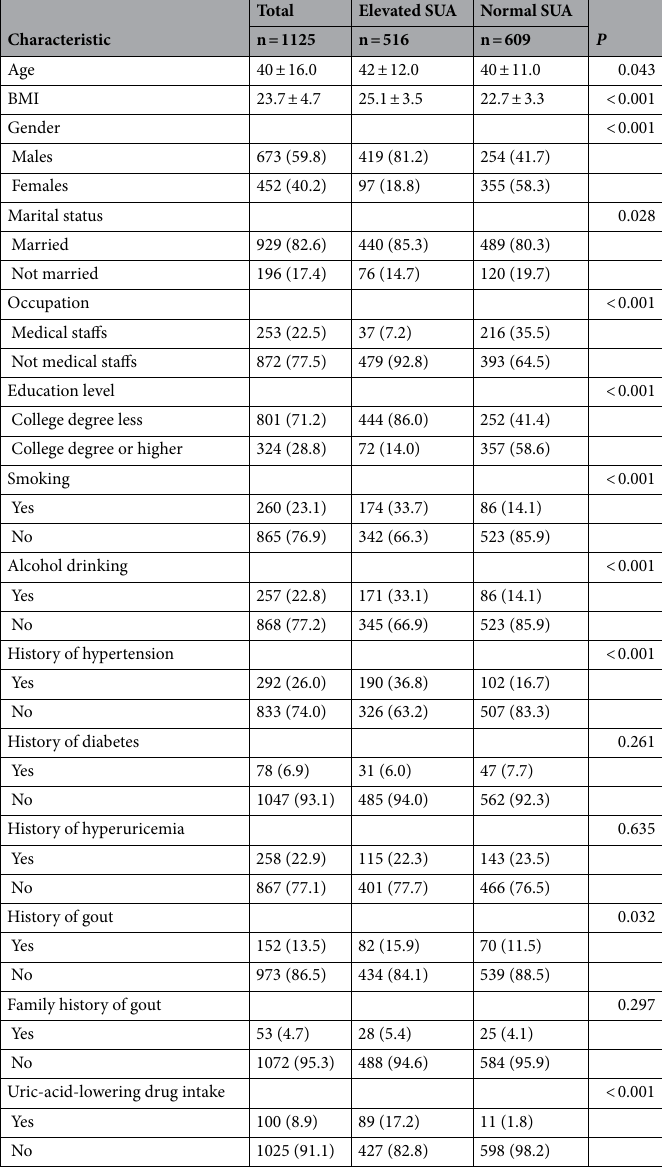
Table 1. The SUA levels of participants. Values are the number (%) or the mean (± SE) unless indicated